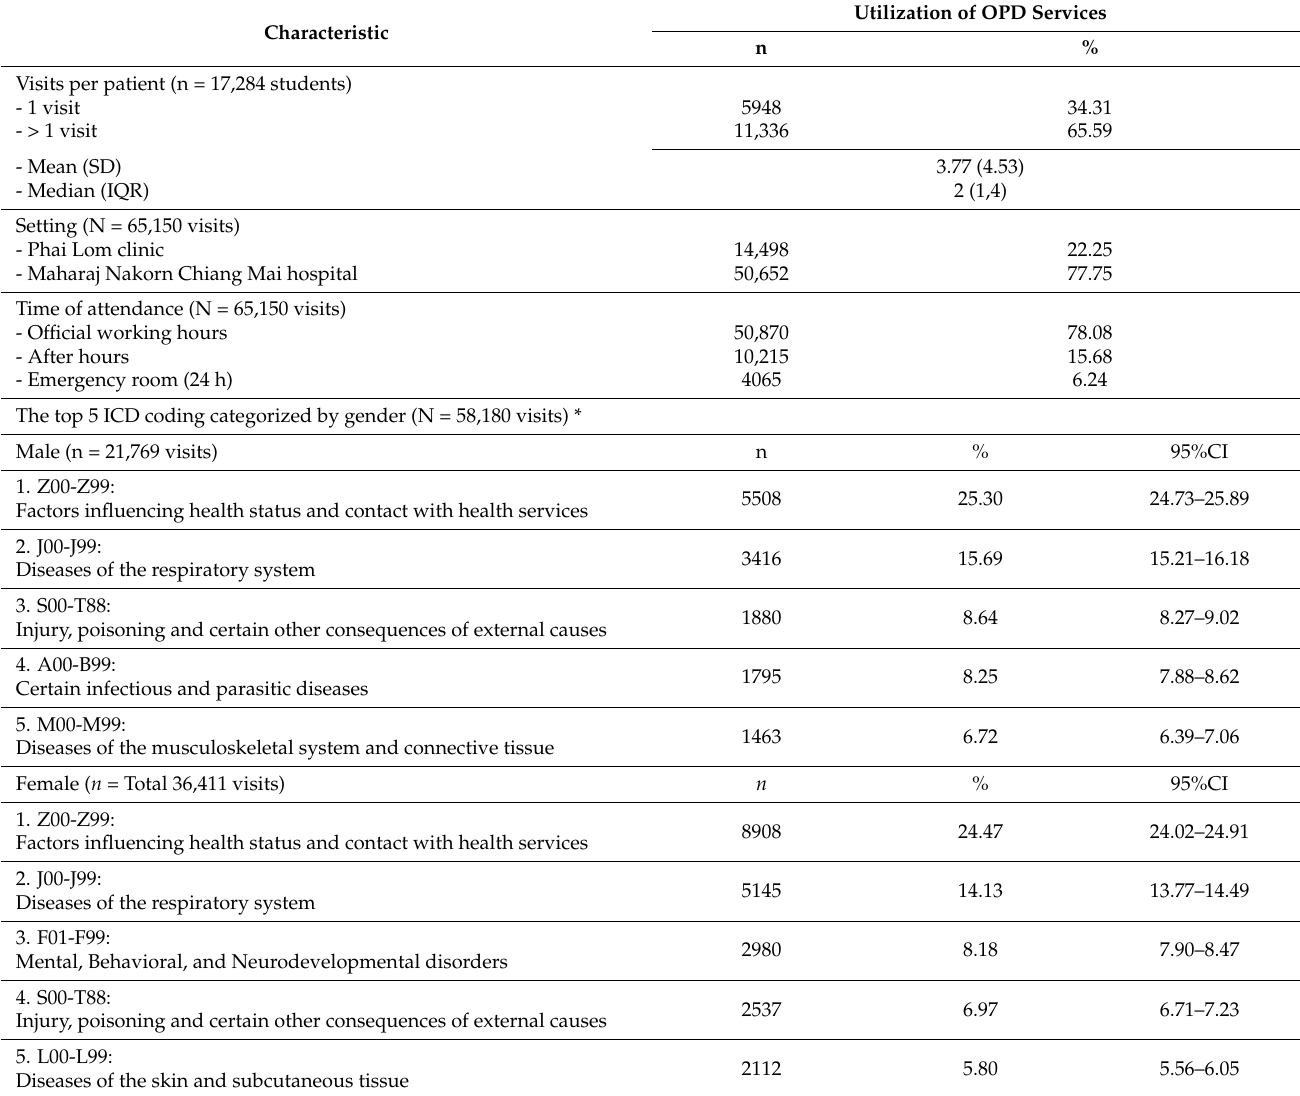
Table 3. The characteristics of utilization of OPD services (17,284 students with 65,150 visits). Characteristic